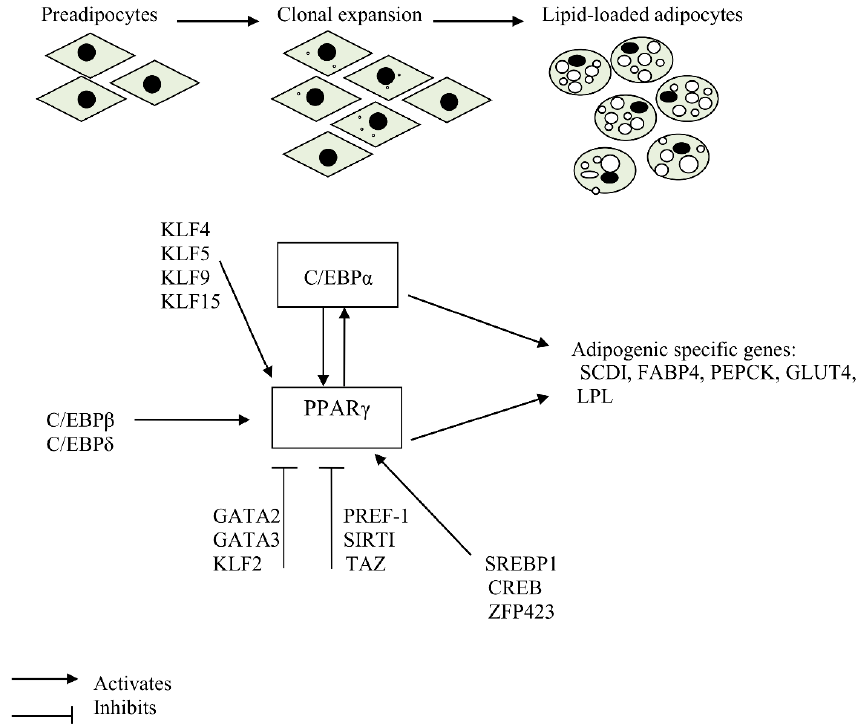
Figure 1. Molecular regulation of adipogenesis.